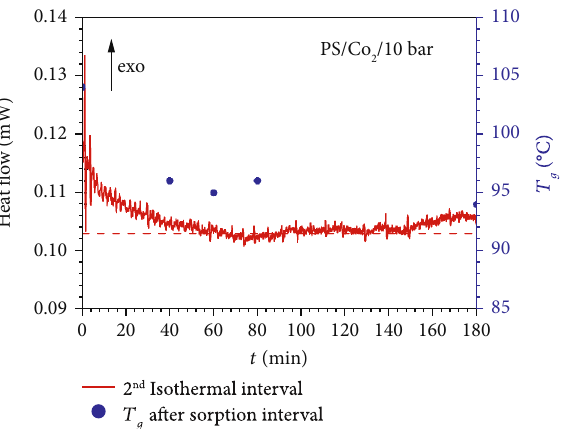
Figure 8: Heat fl ow and glass transition temperature T function of sorption time at constant temperature in a HP-DSC